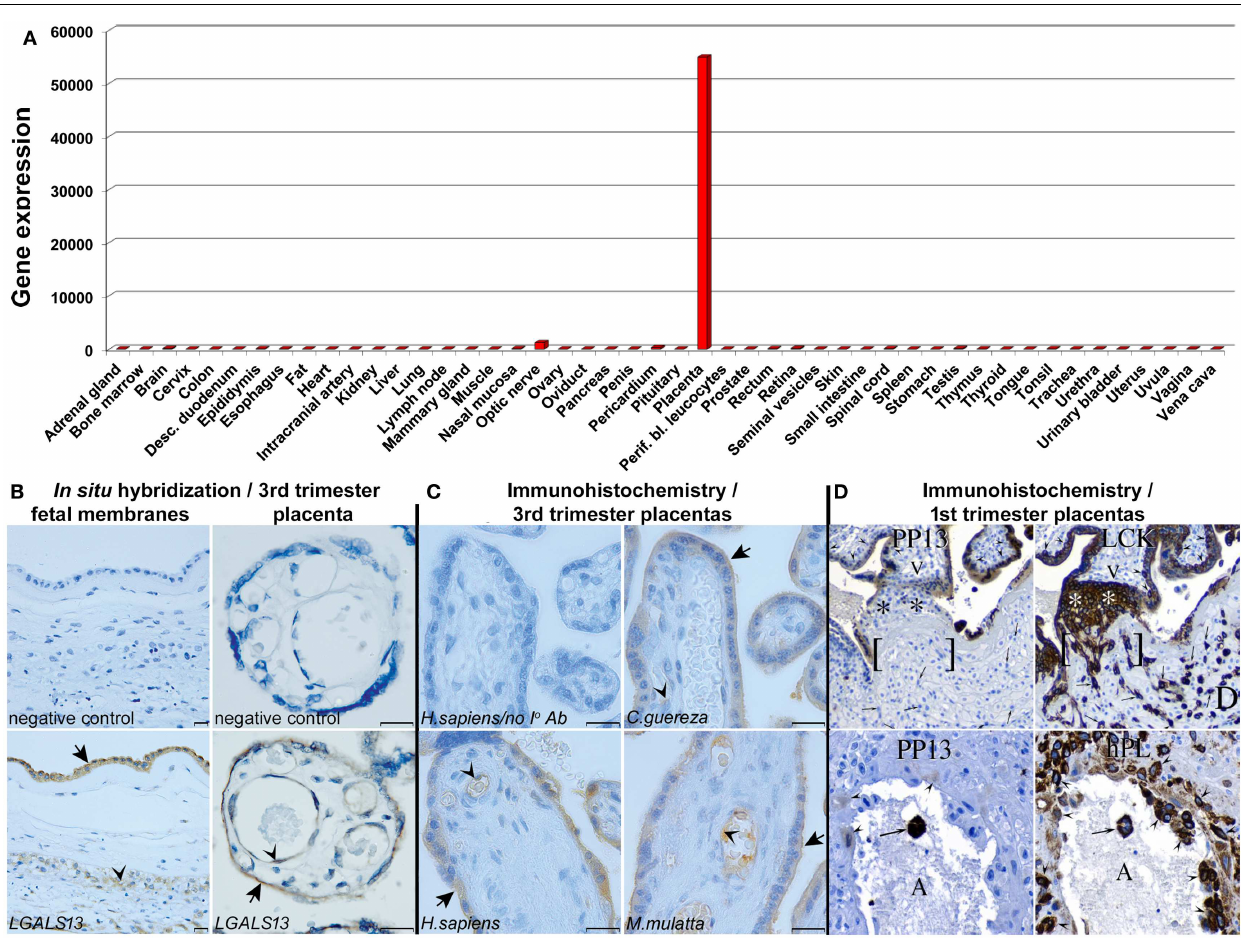
FIGURE 5 | PP13 expression profiling . (A) qRT-PCR on a human 48-tissue cDNA panel uncovered that LGALS13 is predominantly expressed by the placenta.The y axis shows gene expression levels [2 ( − ∆ Ct) ]. (B) In situ hybridization revealed LGALS13 expression in the amnion (arrow) and chorionic trophoblasts (arrowhead) in the fetal membranes in normal term pregnancy (left). In normal term placenta, LGAL13 is predominantly expressed by the syncytiotrophoblast (arrow) and endothelium (arrowhead) (right). Scale bars: 20 µ m. (C) PP13 immunostaining is conserved in the syncytiotrophoblast, its apical membrane (arrows), and the endothelia (arrowheads) of human and anthropoid primate placentas. (Scale bars: 20 µ m.) (D) (Upper panel) Serial sections of a 15week junctional complex stained for PP13 and low molecular weight cytokeratin (LCK). LCK immunostained epithelial cells, including cytotrophoblasts (arrowheads), anchoring trophoblasts (*), early infiltrating trophoblasts [ ], and invasive trophoblasts (arrows) in the decidua (D). Mesenchymal villous core cells (V)